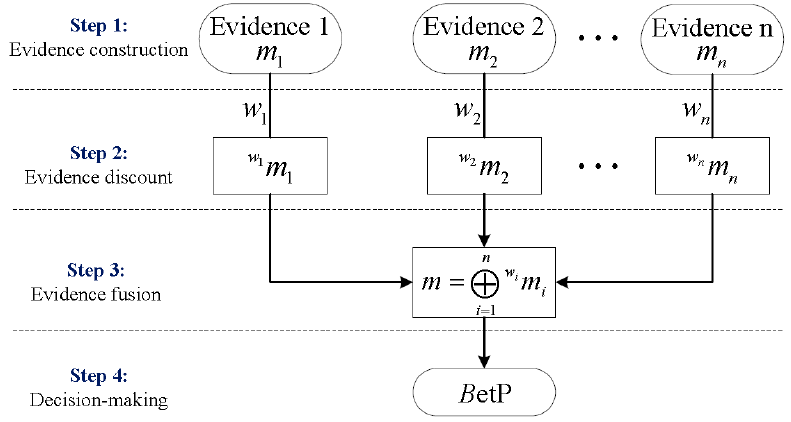
Figure 1. The main framework of evidence